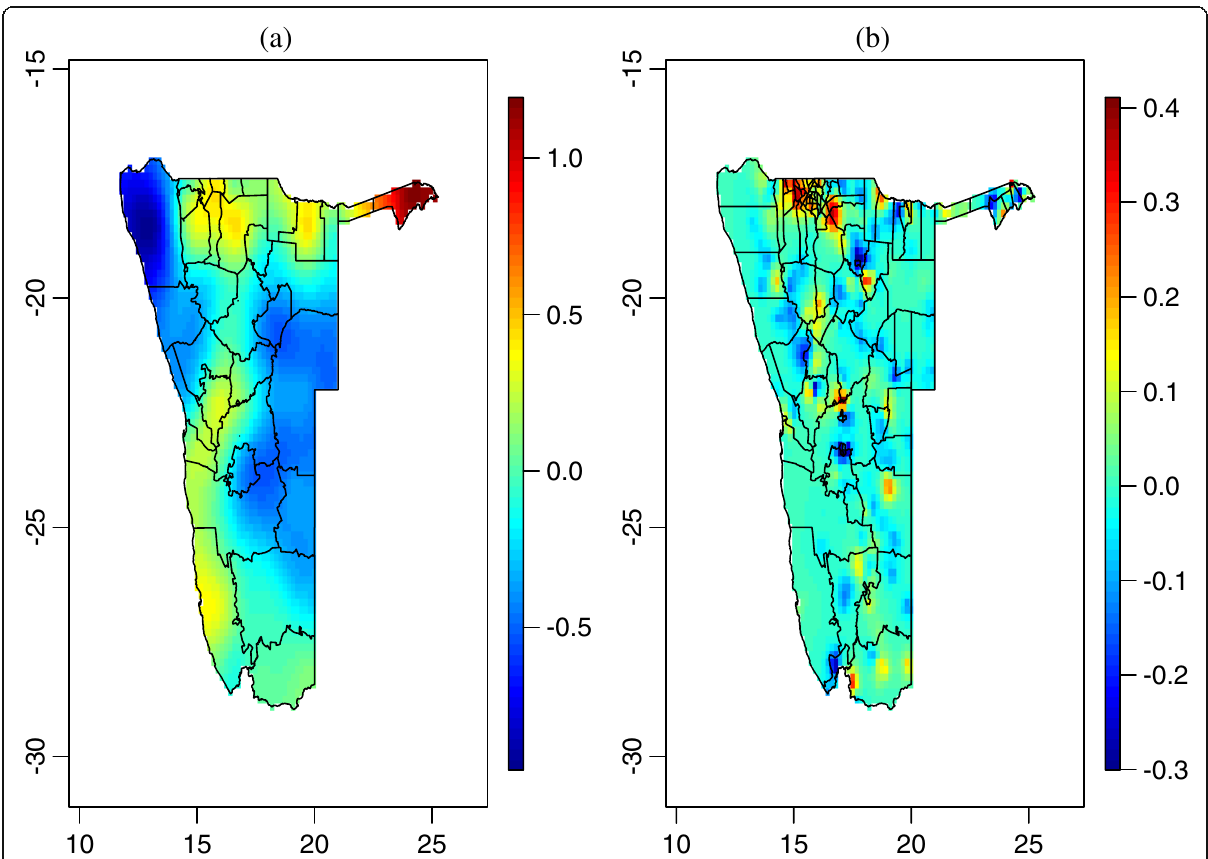
Fig. 7 Posterior means of random effects from bivariate model: ( a ) Spatial random effects (NHSS data); ( b ) spatial random effects (NDHS